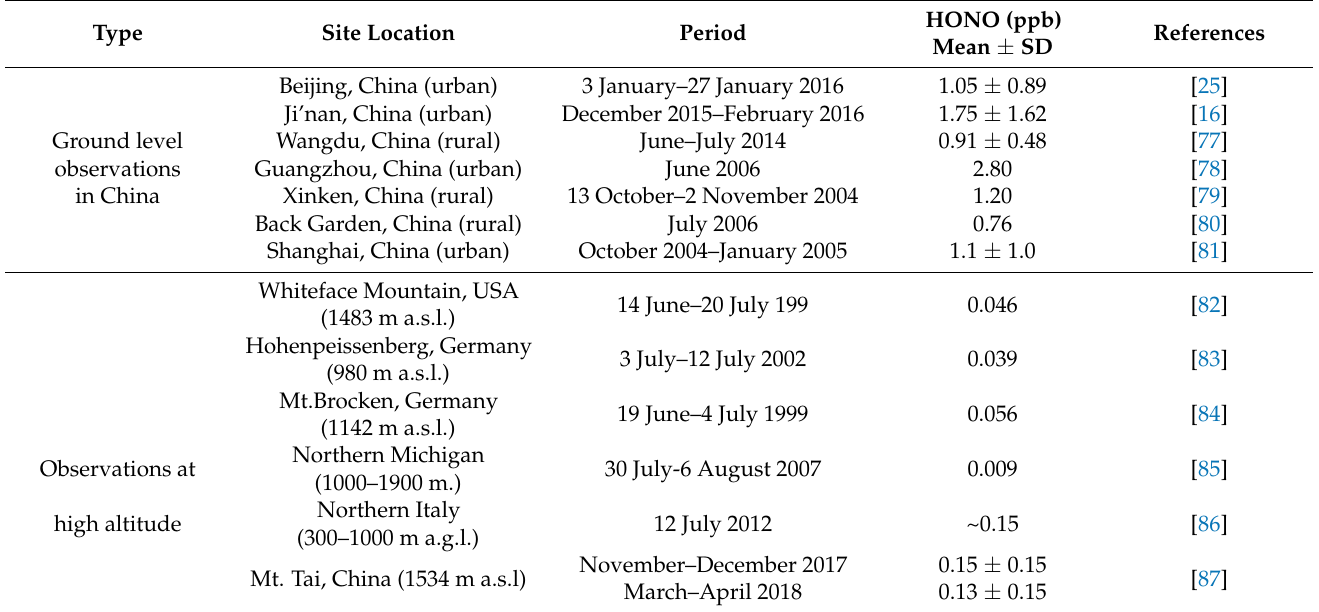
Table 2. Comparison of HONO concentration observed at Shanghai with previous studies at surface and high altitudes. Type Site